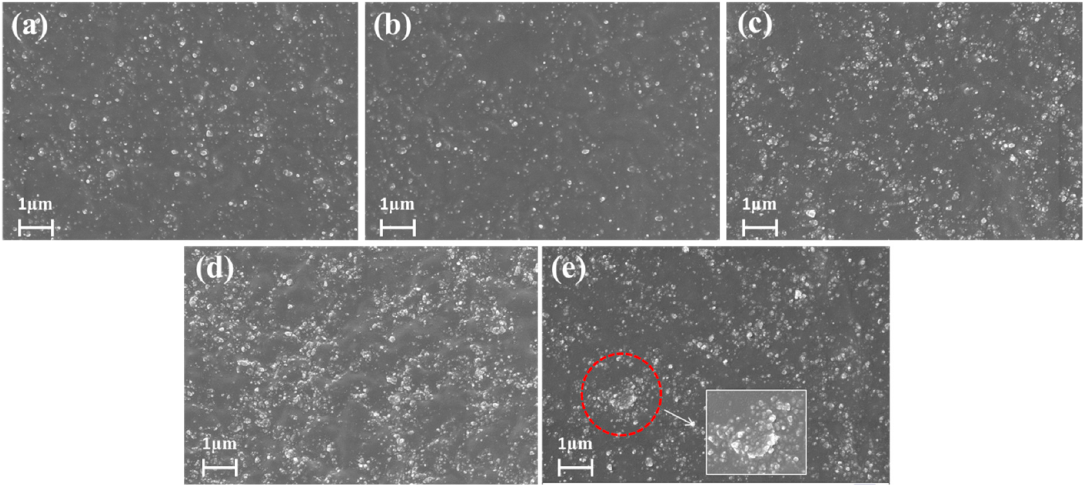
Figure 4. Scanning electron microscopy (SEM) images of SBR/silica nanocomposites: ( a ) SBR/SV1, ( b ) SBR/SV2, ( c ) SBR/SV3, ( d ) SBR/TESPT, and ( e ) SBR/sulfur.